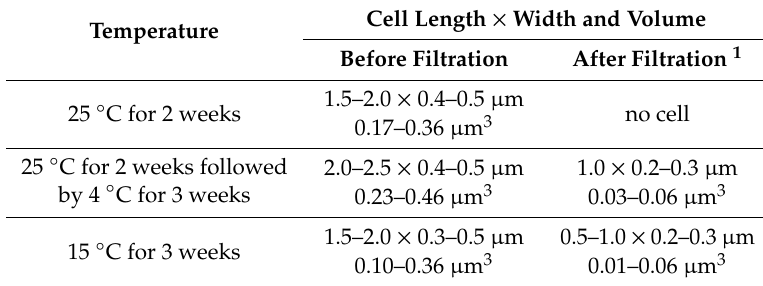
Table 1. Cell size before and after 0.22- µ m filtration under di ff erent culture